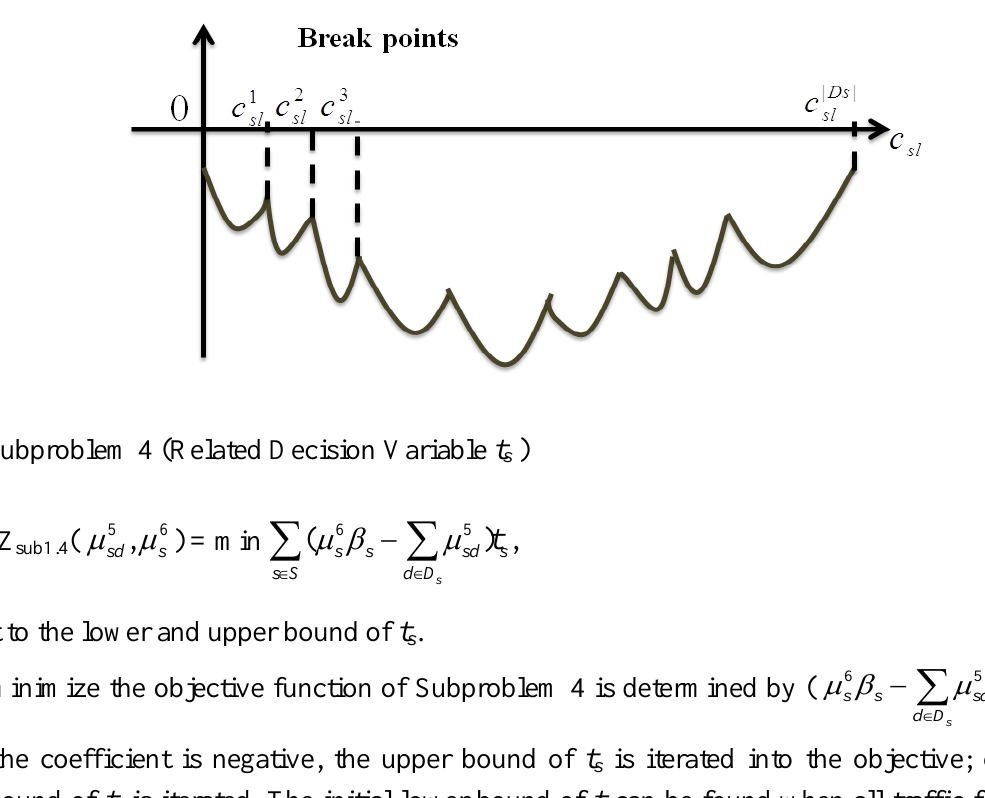
Figure 9. An example of Subproblem 3 considering c